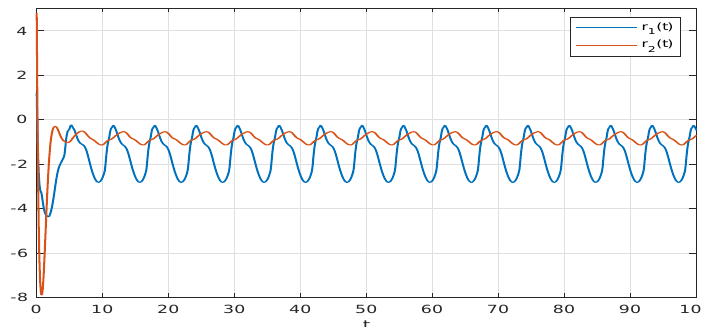
Figure 3. The synchronization error system without the controller.